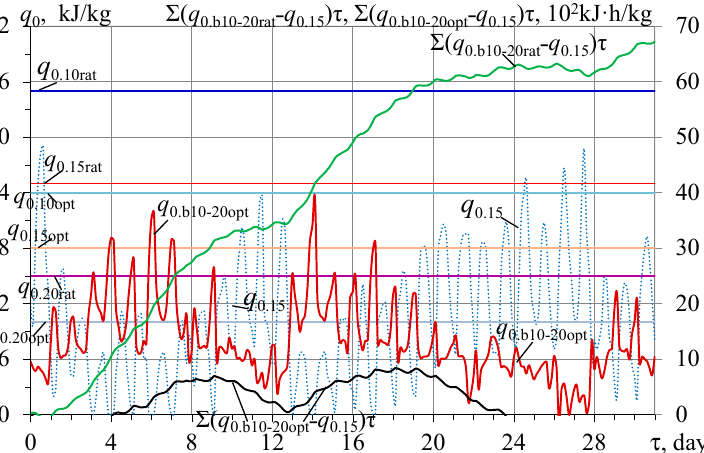
Figure 7. Current specific thermal loads q 0.15 for cooling ambient air to t a 2 = 15 °C, available optimum boost cooling capacities q 0.b10-20opt for precooling air to t a 2 = 20 °C and summarized excess of available accumulated refrigeration energy according to optimum Σ ( q 0.b10-20opt − q 0.15 ) τ and rational Σ ( q 0.b10-20rat − q 0.15 ) τ designing: q 0.b10-20opt = q 0.10opt − q 0.10-20 ; q 0.10-20 = q 0.10 − q 0.20 .